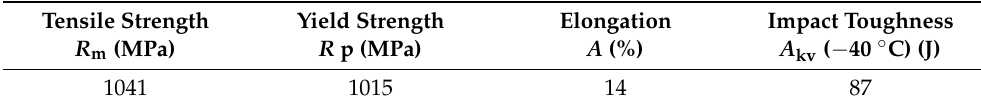
Table 2. Mechanical properties of the Q960E steel.